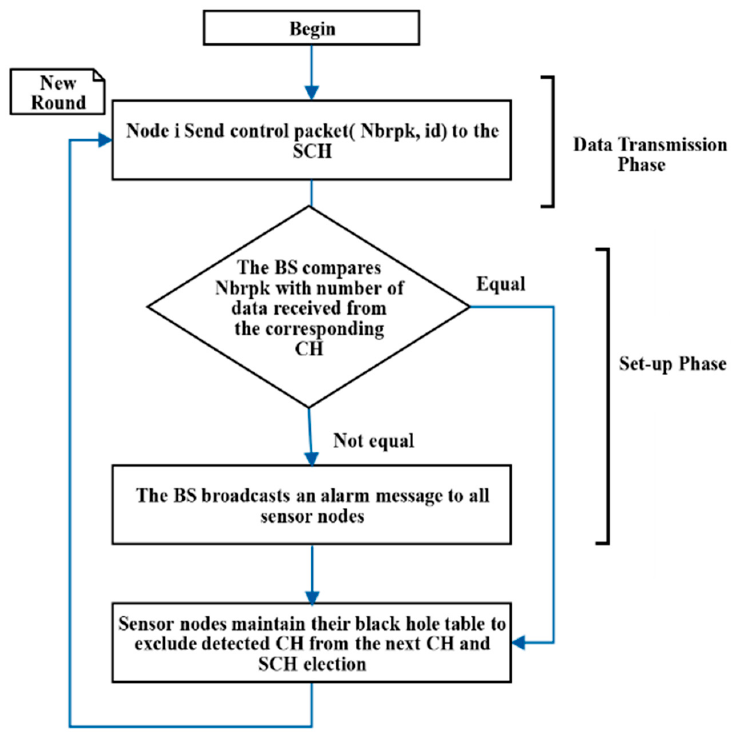
Figure 4. SCH-based intrusion detection scheme (SCH-IDS).